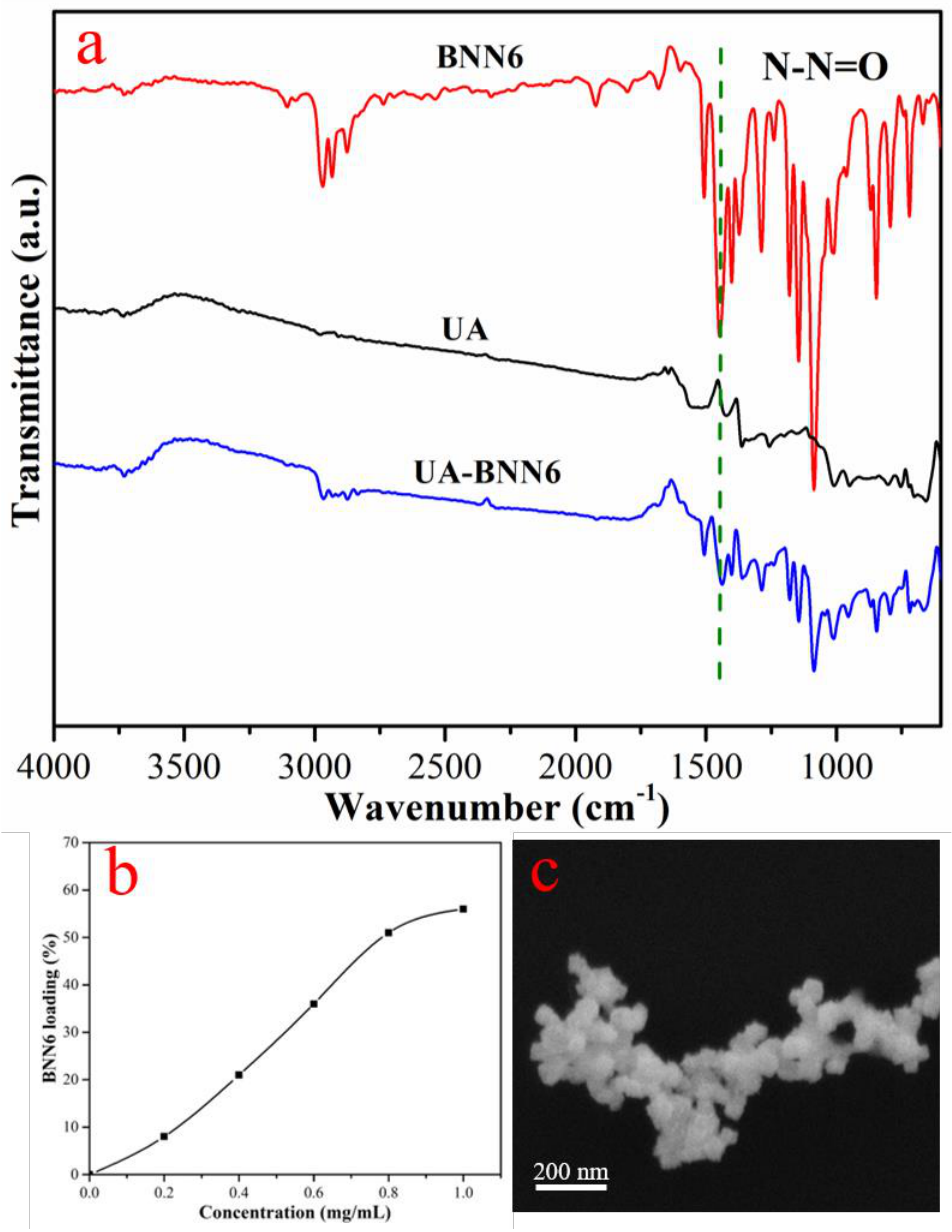
Figure 2. ( a ) The FTIR spectra of BNN6, UA and UA − BNN6. ( b ) The adsorption curve of UA to BNN6. ( c ) The SEM image of UA − BNN6.